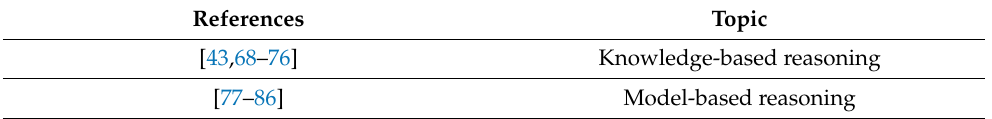
Table 3. The reasoning-based diagnostic work reviewed in Section